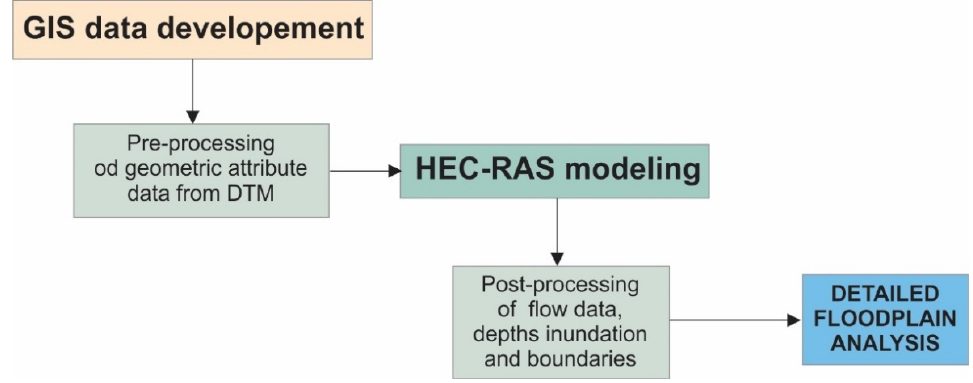
Figure 4. A general diagram of the course of calculation organization.